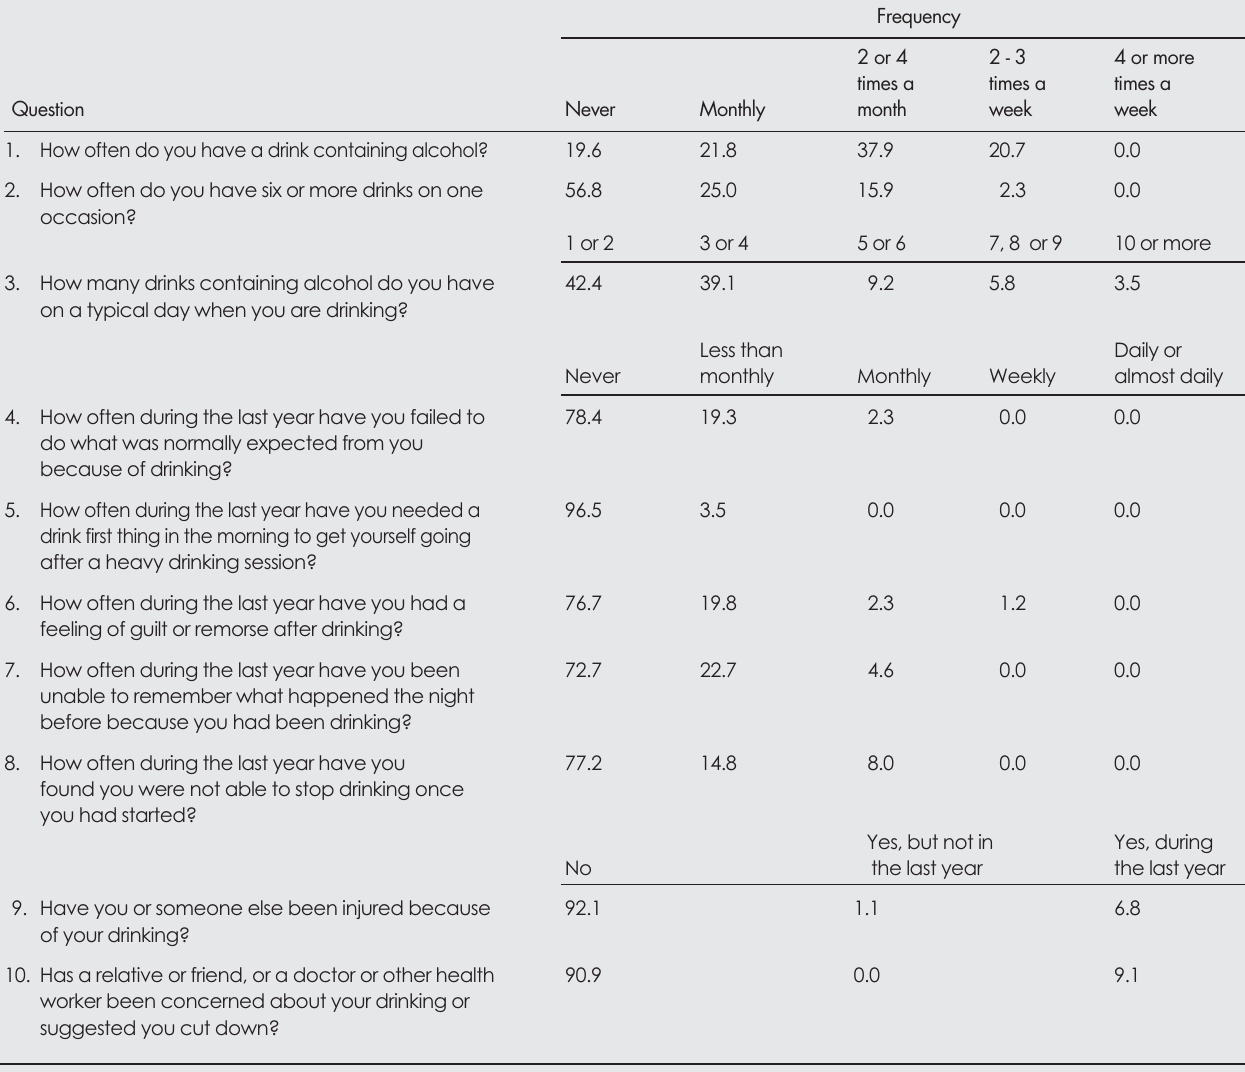
Table II. Results of the Alcohol Use Disorders Identification Test in percentages ( N =